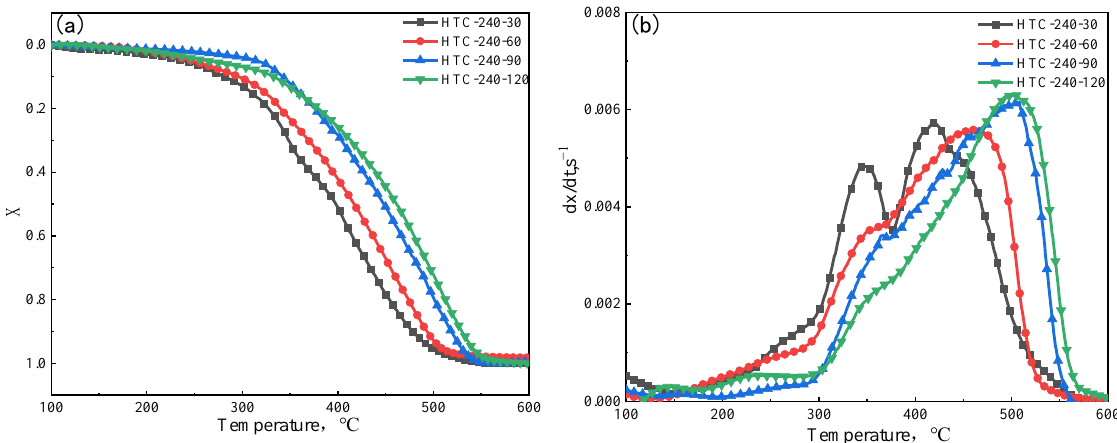
Figure 7. TG and DTG curves of hydrochar under different holding times: ( a ) TG curves; ( b ) DTG curves